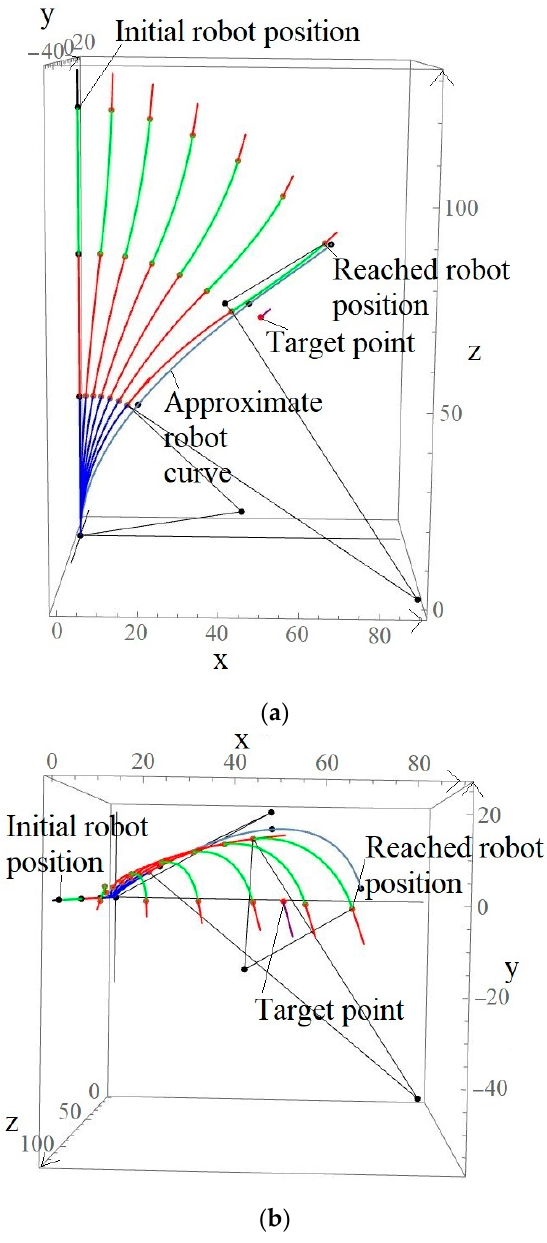
Figure 23. Robot segments’ motion from the initial position to the target position. The light blue curve illustrates the robot spine curve. The calculated robot segment arc curves are blue, red, and green: ( a ) robot motion side view when the robot is straight in the initial position; ( b ) robot motion top view when the robot is initially vertically straight.